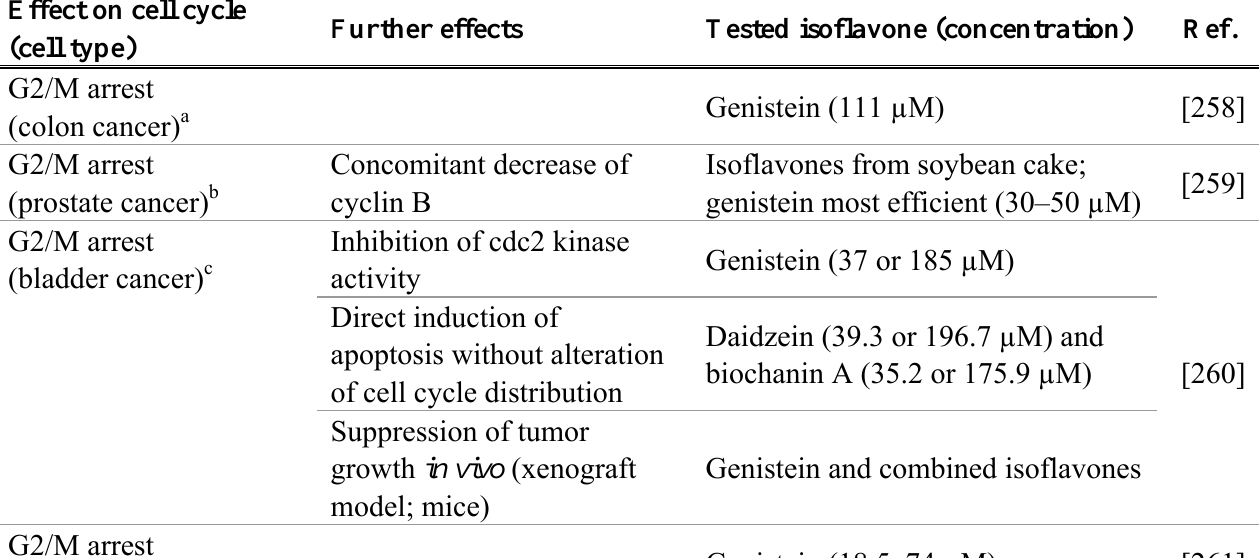
Table 4. Effect of isoflavones on the cell cycle in human